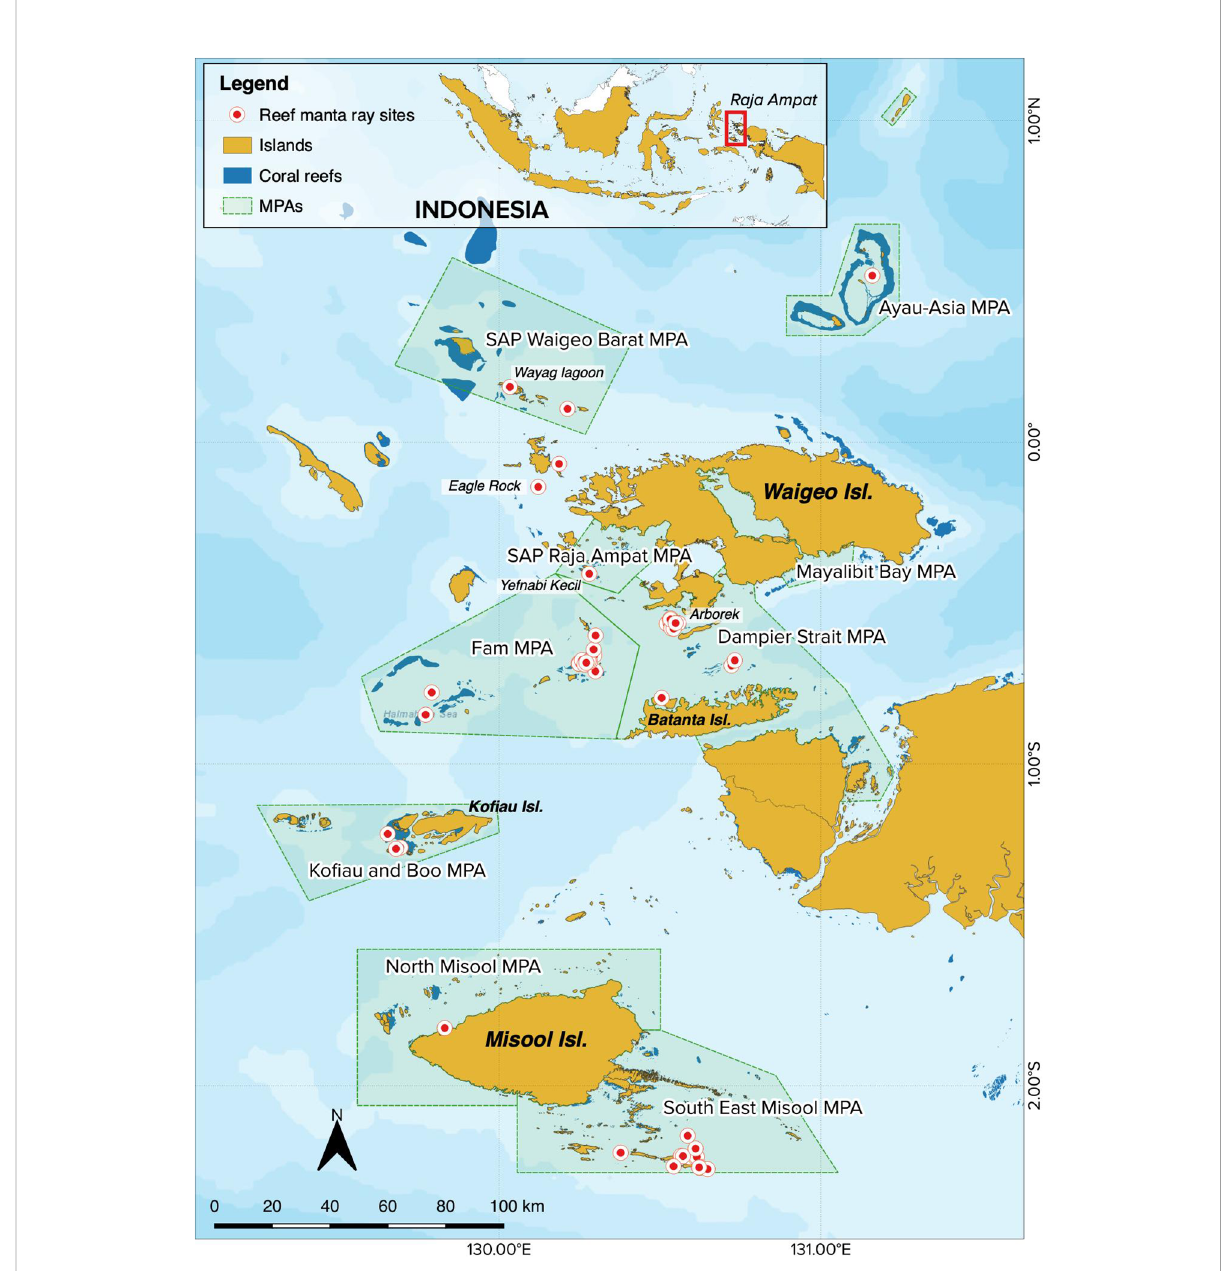
FIGURE 1 Map of the Raja Ampat Archipelago in West Papua, Indonesia, denoting both the network of nine MPAs (shaded green polygons) and the 51 sites from which M. alfredi photo-ID data have been collected (red dots with white